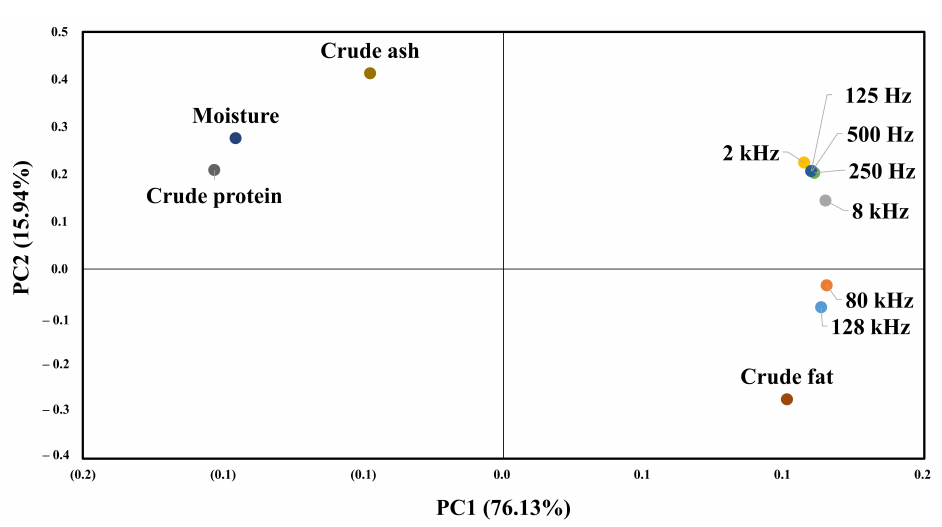
Figure 9. PCA for the proximate composition results and